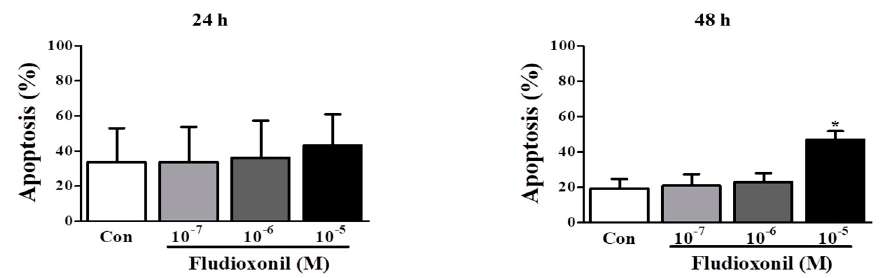
Figure 4. Apoptosis of Jurkat T cells and Ramos B cells by fludioxonil. ( A , B ) The results of flow cytometry analysis of annexin V and PI staining in Jurkat T cells and Ramos B cells treated with fludioxonil (10 − 7 –10 − 5 M) for 24 or 48 h are shown. The x axis is annexin V and the y axis is PI. ( A ) Jurkat T cells ( B ) Ramos B cells. The live cell populations are in the lower-left quadrant (Annexin V – / PI – ), the cells in early apoptosis are in the lower-right quadrant (Annexin V + / PI – ), and late apoptosis is shown in the upper-right quadrant (Annexin V + / PI + ). Statistical graphs of annexin V / PI staining are shown, and data present the apoptosis cell ratio from three independent experiments. Apoptotic cells include annexin V + / PI – cells and annexin V + / PI + cells. The data are shown as the means ± standard deviation (SD) of three independent experiment. * p < 0.05 as compared with the control.